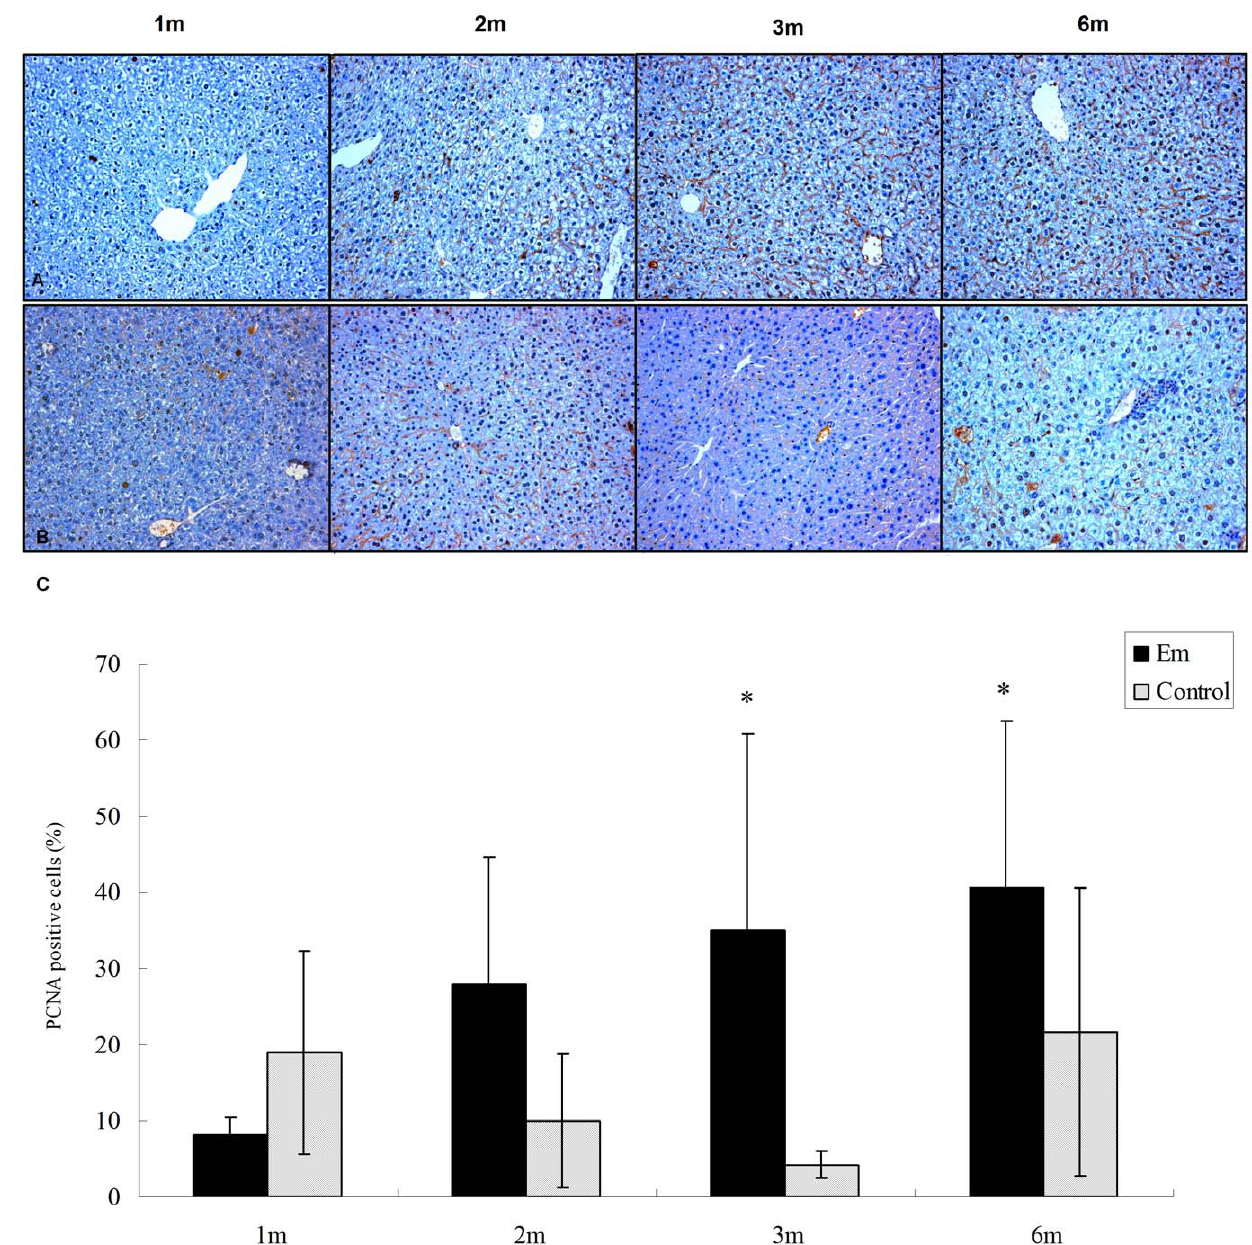
Figure 3. Proliferating Cell Nuclear Antigen (PCNA) expression by hepatic cells in the liver from E.multilocularis infected mice (Em) and non-infected mice (control) (histo-immunochemical analysis). A. Hepatic cells close to the parasitic lesions were strongly labeled by the anti-PCNA antibody in E. multilocularis infected mice; all cells with a dark-blue/black nucleus are positive cells; some of them indicated by an arrow (initial magnification: 6 20). B. Hepatic cells very little expressed PCNA in non-infected mice (initial magnification: 6 20). C. Quantitative expression of PCNA was significantly higher in the liver cells of E. multilocularis infected mice than in those of non-infected mice at month 3 and 6 (* p , 0.05).